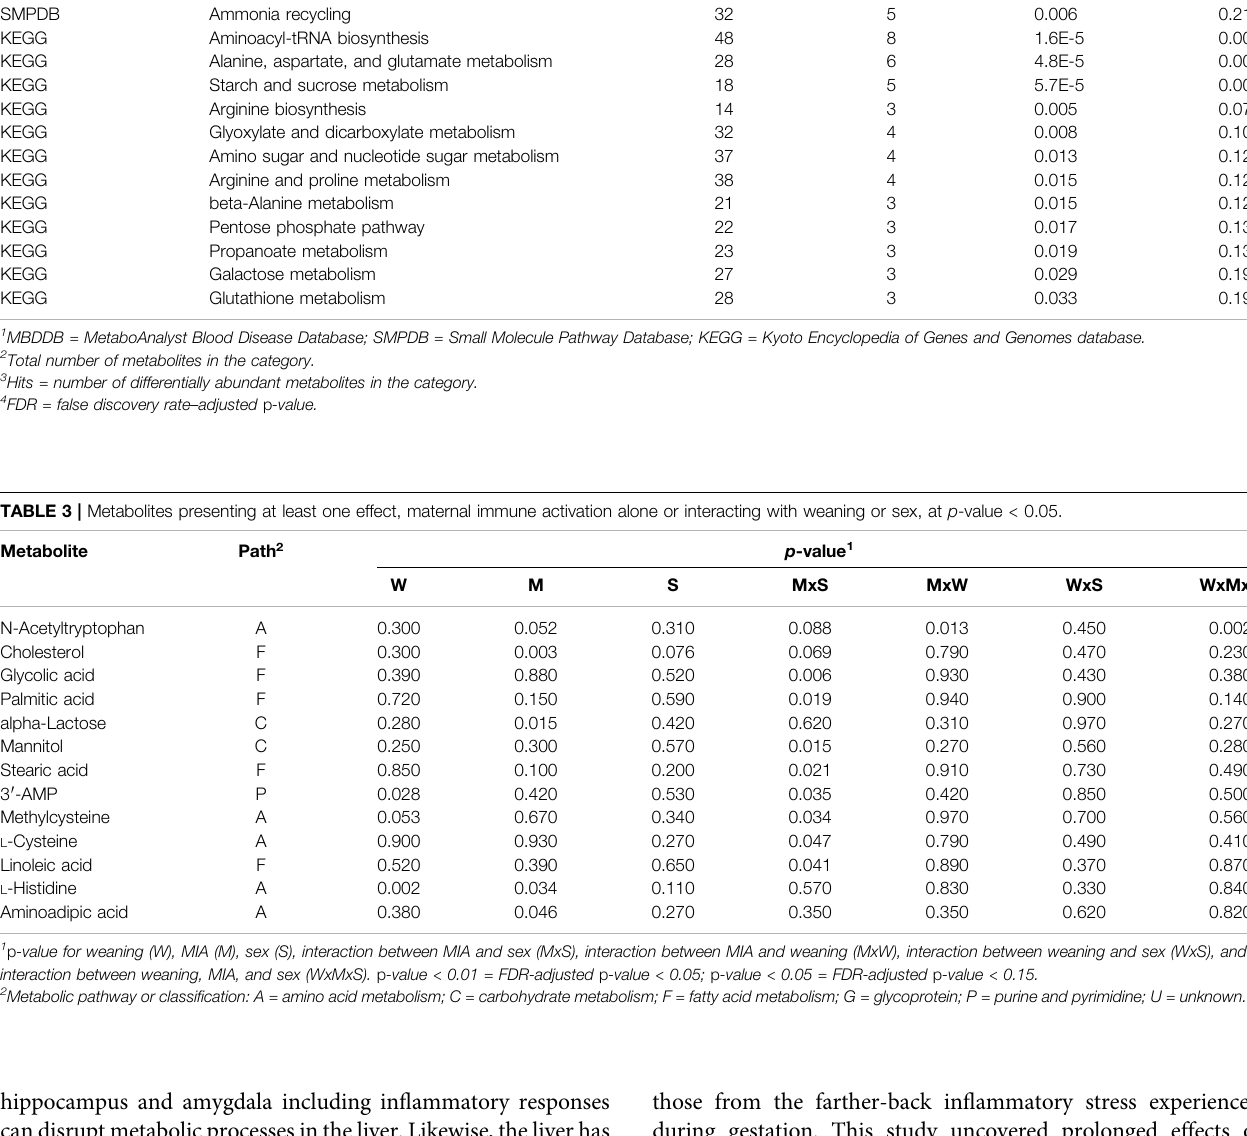
TABLE 2 | Pathways enriched at p -value < 0.05 and including at least three metabolites among the molecules associated with weaning effects. Database 1